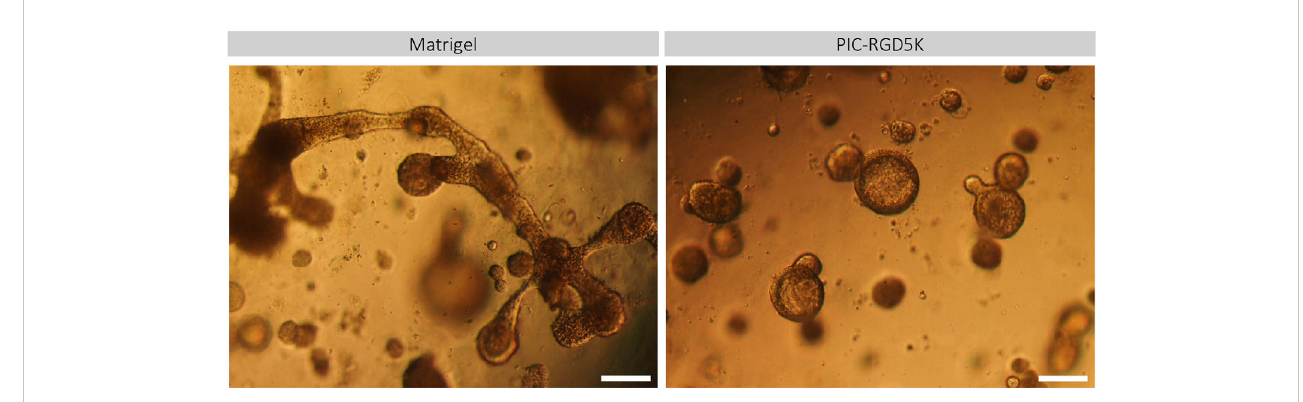
FIGURE 2 PIC-derivedorganoidscannotgeneratefunctionallymatureSGcelllineages.RepresentativeimagesofMatrigel-andPIC-derivedSGOsattheendofthe differentiation assay in Matrigel after 18 days in culture. Scale bar = 200